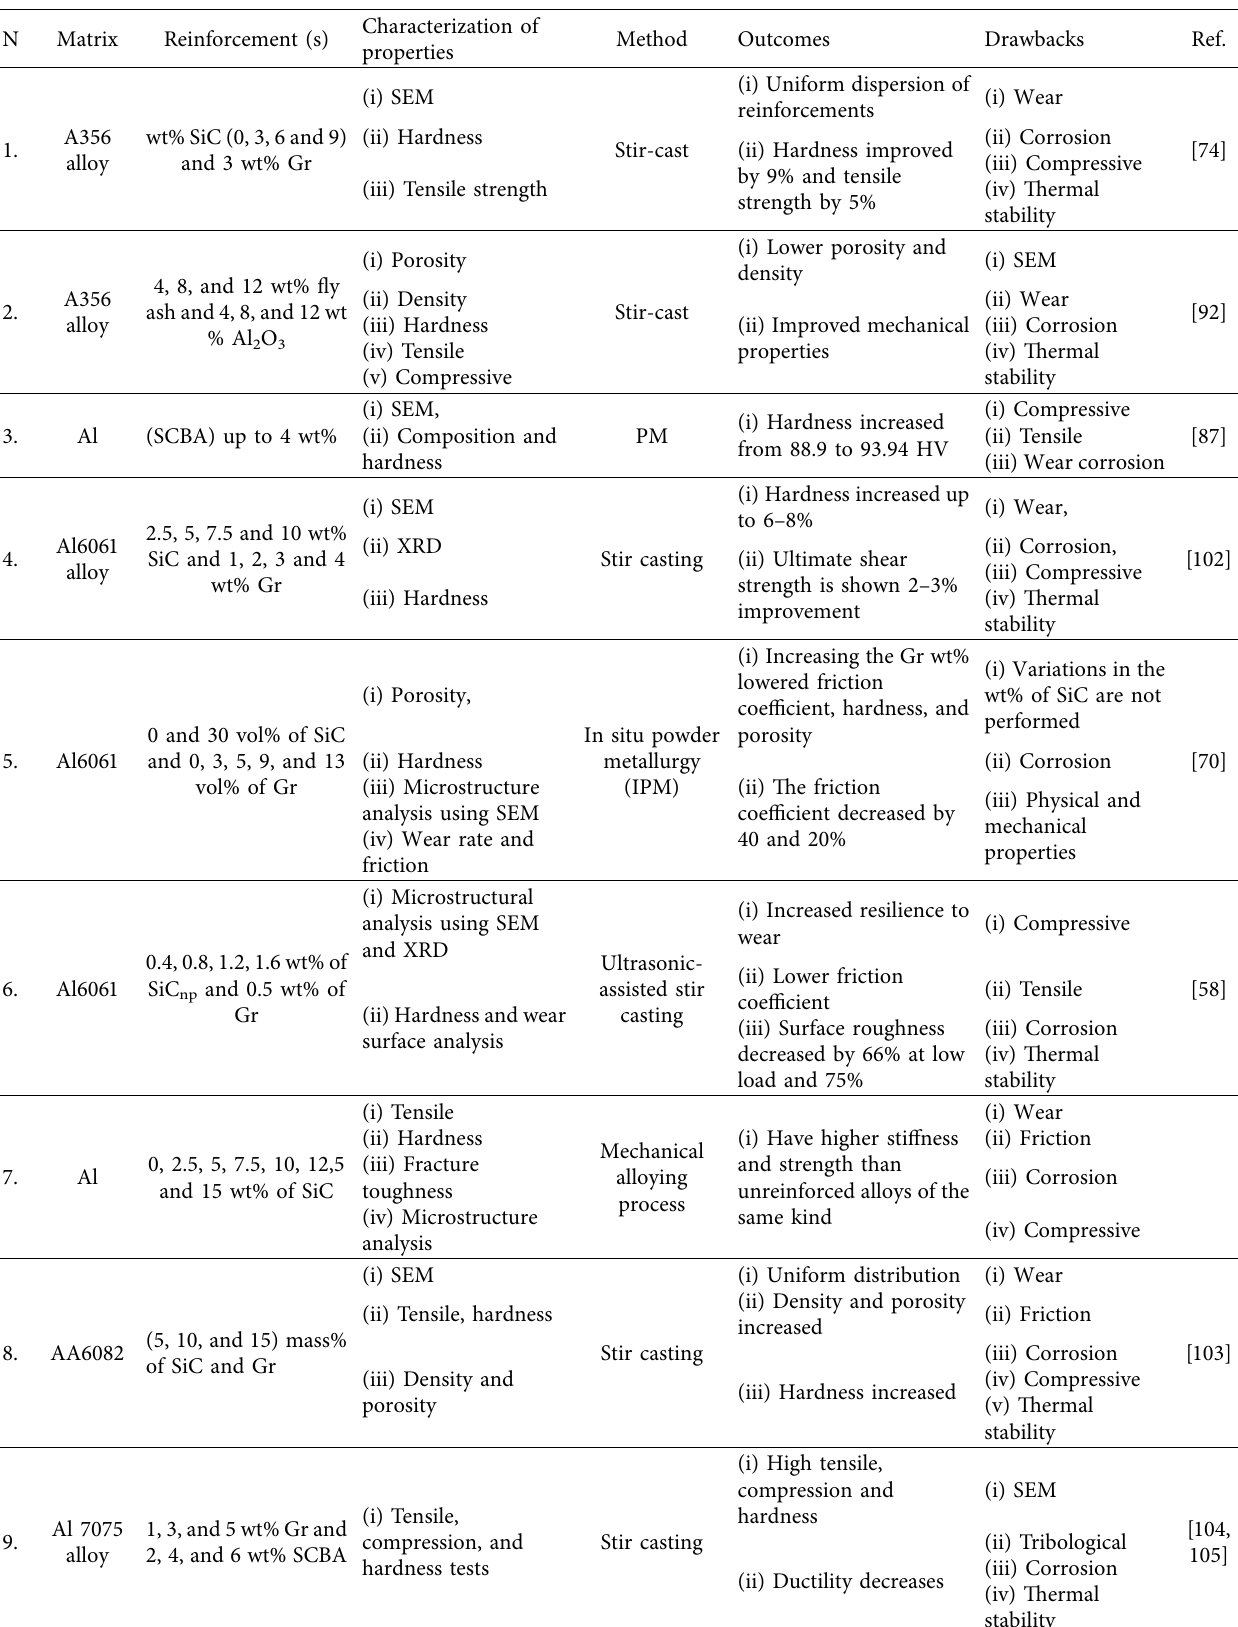
Table 6: Summary of properties, processing methods, outcomes, and research drawbacks in particulate-reinforced AMCs and HAMCs. N